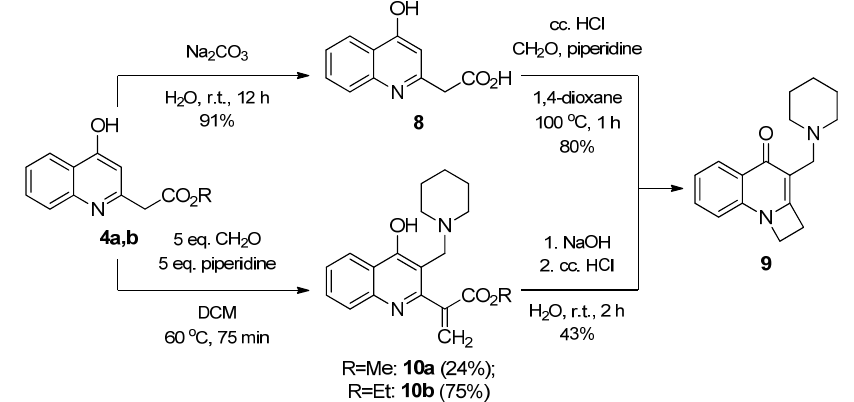
Scheme 2. The reaction of 2-(4-hydroxyquinolin-2-yl) acetates with paraformaldehyde in the presence of